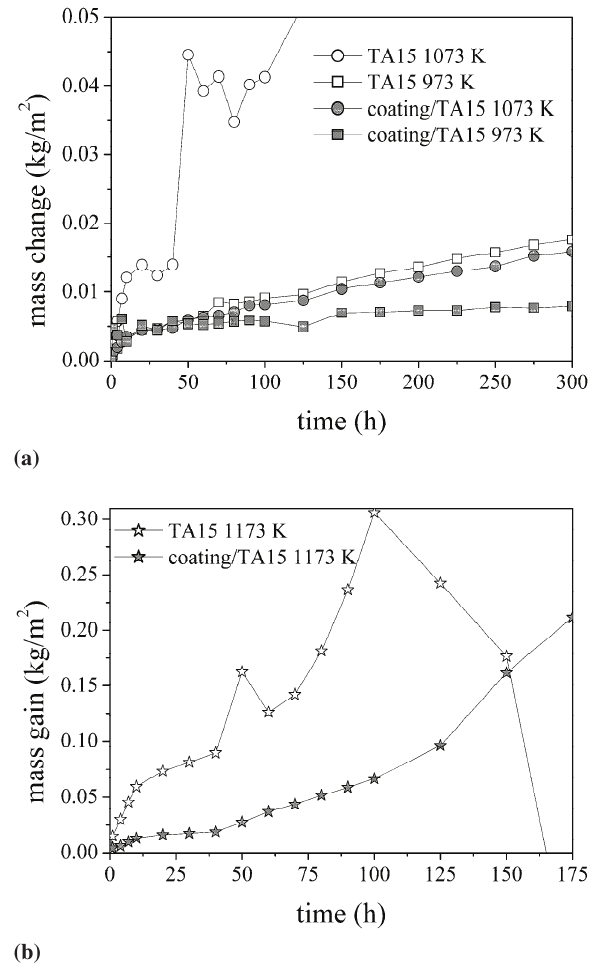
Figure 4. The interrupted oxidation kinetic curves, mass gain versus time, of the TA15 alloy and the coating/TA15 at high temperatures in air. (a) 973 and 1073 K; (b) 1173 K.